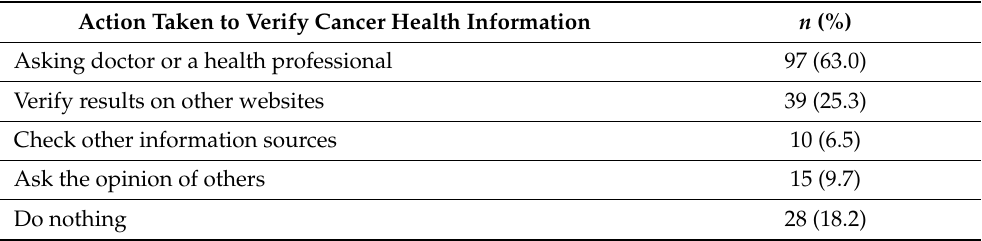
Table 3. Distribution of the respondents according to action taken to check reliability and trustwor- thiness of the cancer health information acquired from the Internet.